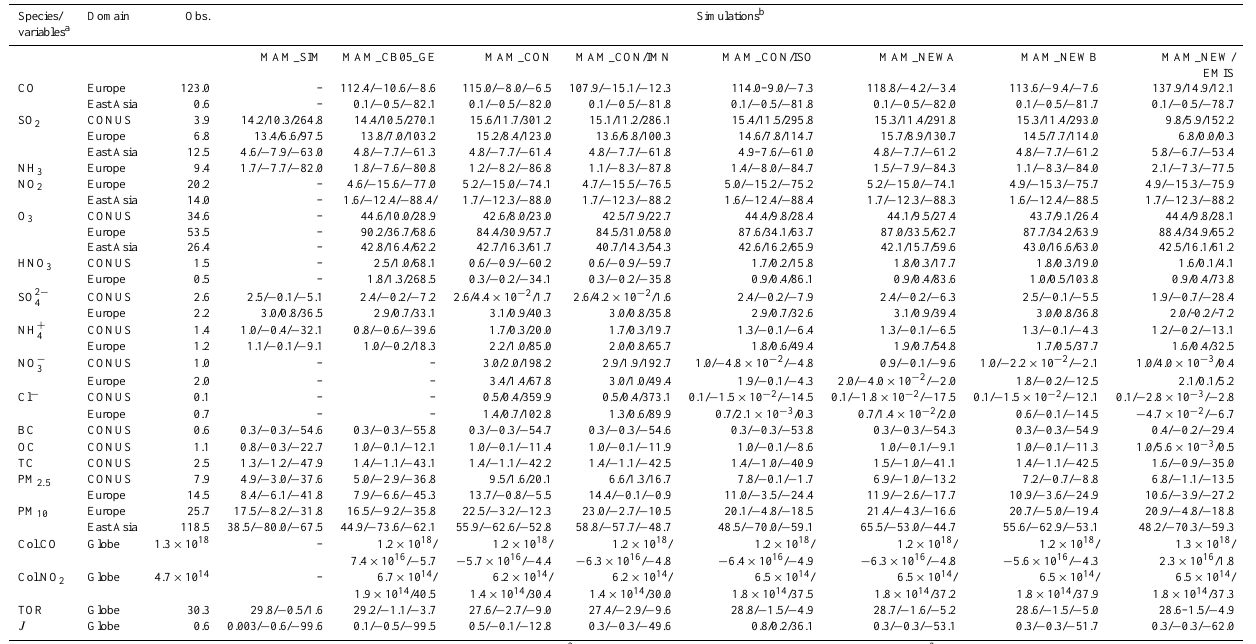
Table 3. Mean bias (MB) and normalized mean bias (NMB, in %) of chemical predictions for the 2001 simulations. Species/ Domain